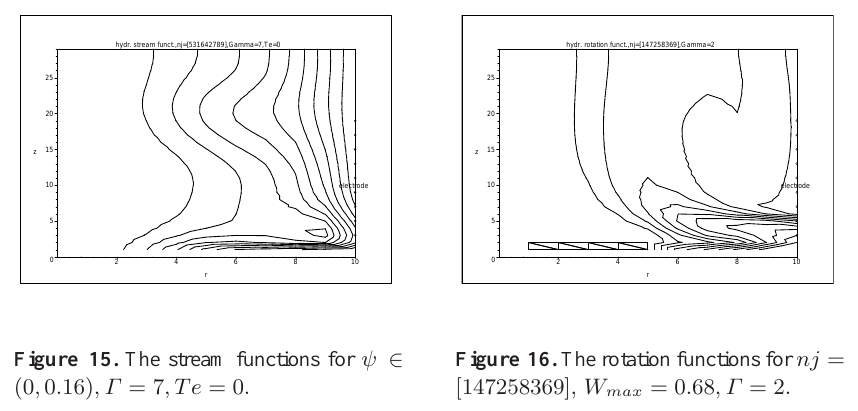
hydr. rotation funct.,nj=[147258369],Gamma=2